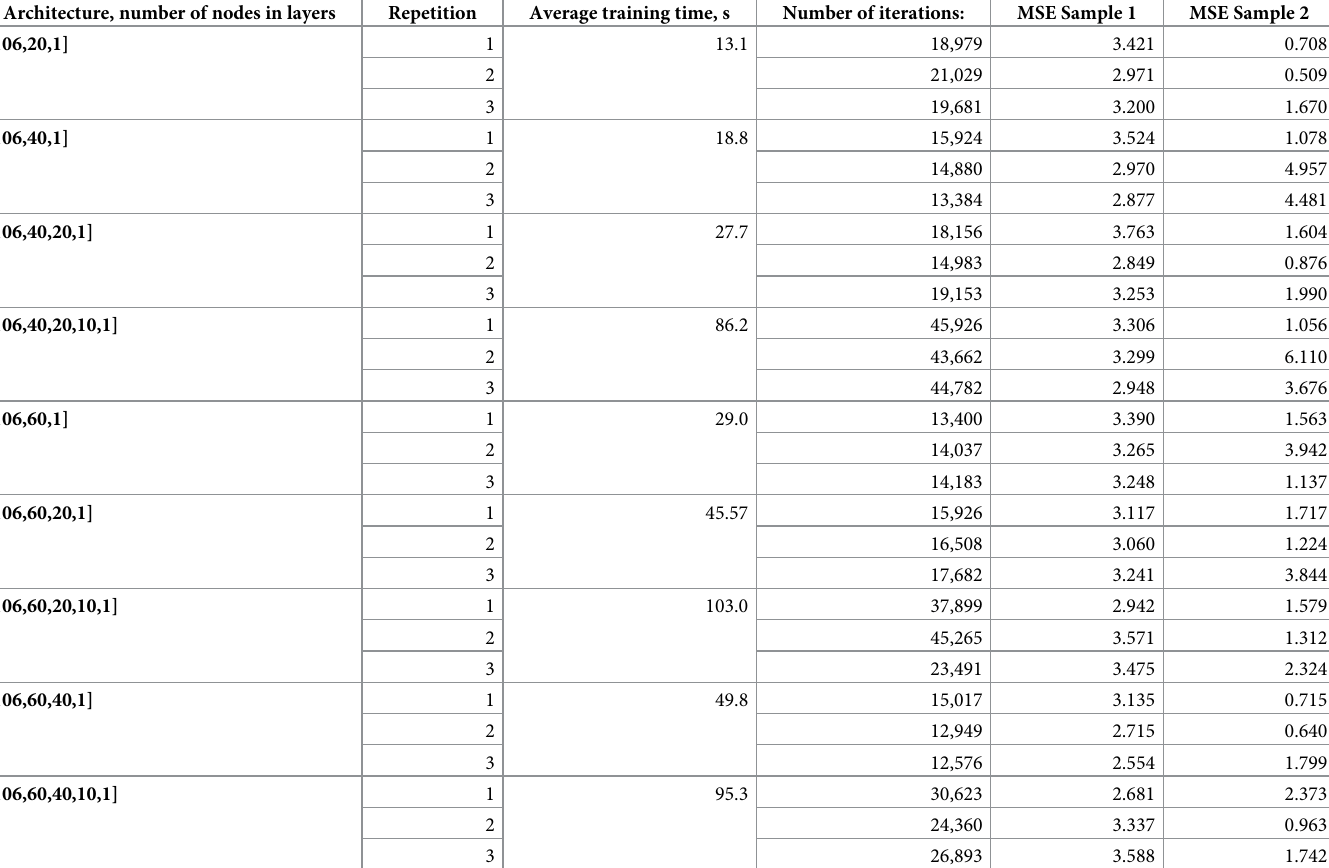
Table 1. Results of parametric analysis (training with data of Sample 1, Max error =